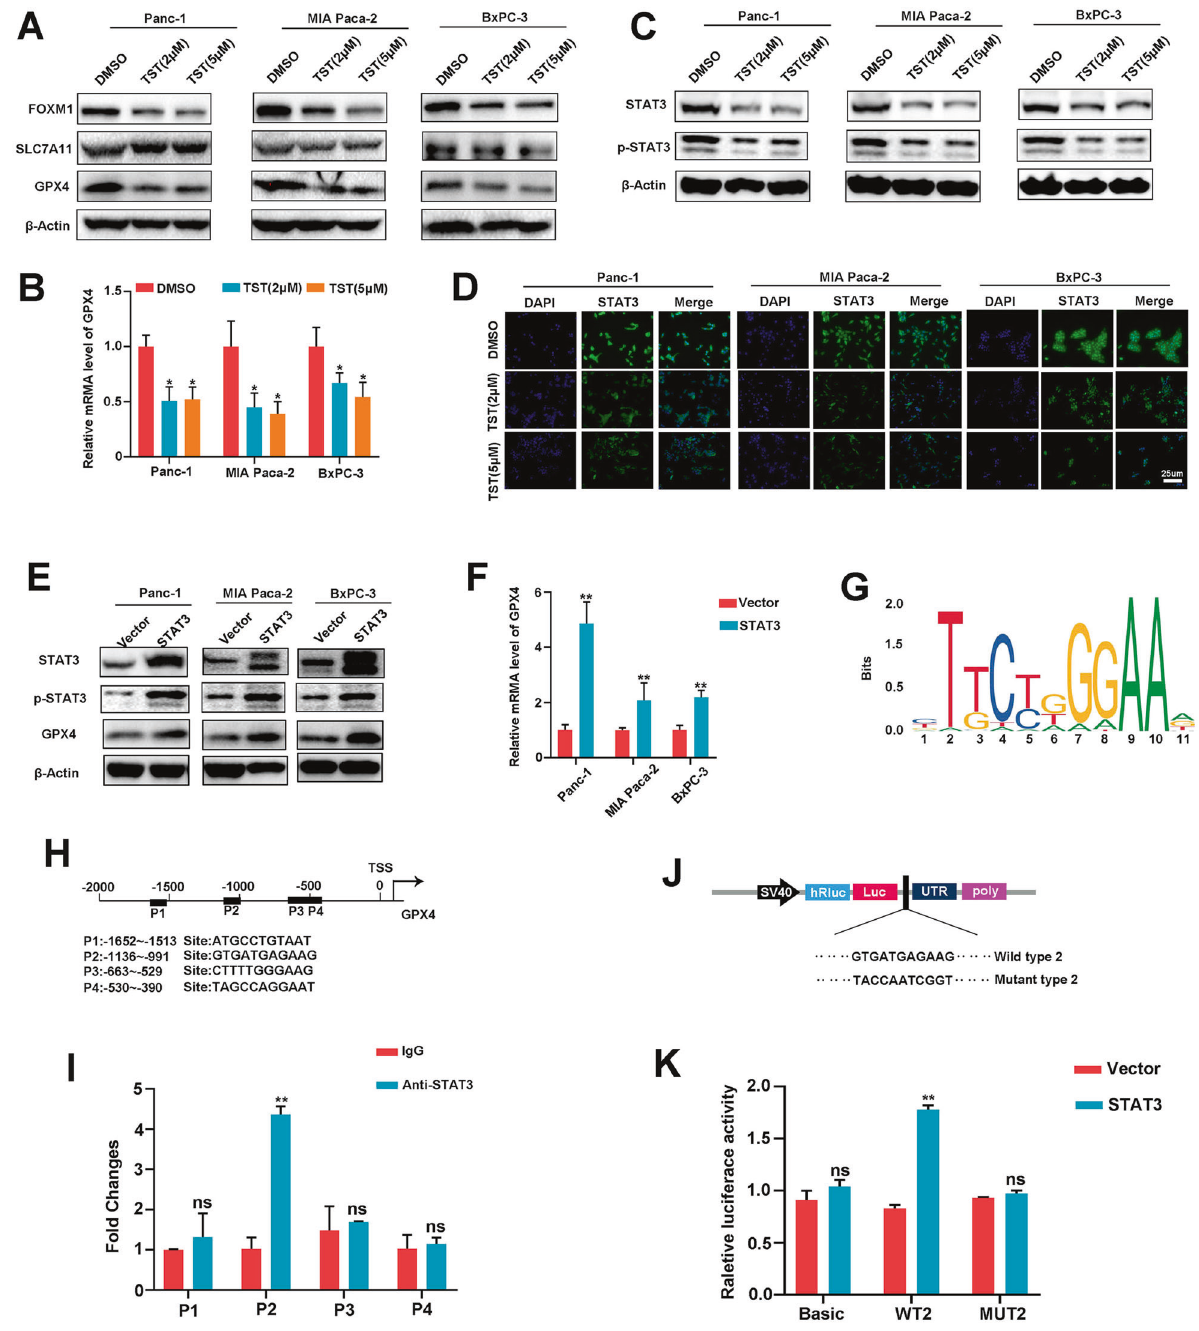
Fig. 3 Thiostrepton activates the STAT3 – GPX4 signalling pathway. A Western blotting analysis of FOXM1, SLC711A, and GPX4 protein levels, B qRT-PCR analysis of the GPX4 mRNA expression level, and C Western blotting analysis of the STAT3 and p-STAT3 protein levels in Panc-1, MIA PaCa-2, BxPC-3 cells treated with TST (DMSO, 2, or 5 μ M). D Representative IF images showing the expression of STAT3. The second antibody was labelled with FITC (green), and the nuclei were stained with DAPI (blue). E and F Western blotting and qRT-PCR analyses of the change in GPX4 expression caused by STAT3 overexpression in pancreatic cancer. G and H A conserved STAT3-binding motif was predicted by JASPAR, and schematic images of the potential STAT3 binding sites in the promoter of GPX4 are shown. I ChIP analysis of STAT3 occupancy at the GPX4 promoter in Panc-1 cells. J Schematic images of luciferase reporter plasmids containing STAT3 binding sites (WT and MUT) in the GPX4 promoter region. K Luciferase reporter assays of 293T cells overexpressing STAT3 and transfected with reporter plasmids containing WT and MUT GPX4 promoters (* P < 0.05, ** P < 0.01, and ns: not signi fi cant). region might be the binding site for STAT3 rather than P1, P3, or (http://jaspar.genereg.net/) revealed four putative motifs (P1 – P4) P4. (Fig. 3I). Finally, we designed luciferase reporter gene plasmids in the GPX4 promoter (Fig. 3G, H). Therefore, ChIP – qPCR was containing the P2 (WT2) site and mutant (MUT2) site (Fig. 3J) and designed to con fi rm the STAT3-binding site in the GPX4 promoter transfected them into 293T cells. By comparing fl uorescence region, and the results con fi rmed that the P2 site of the promoter